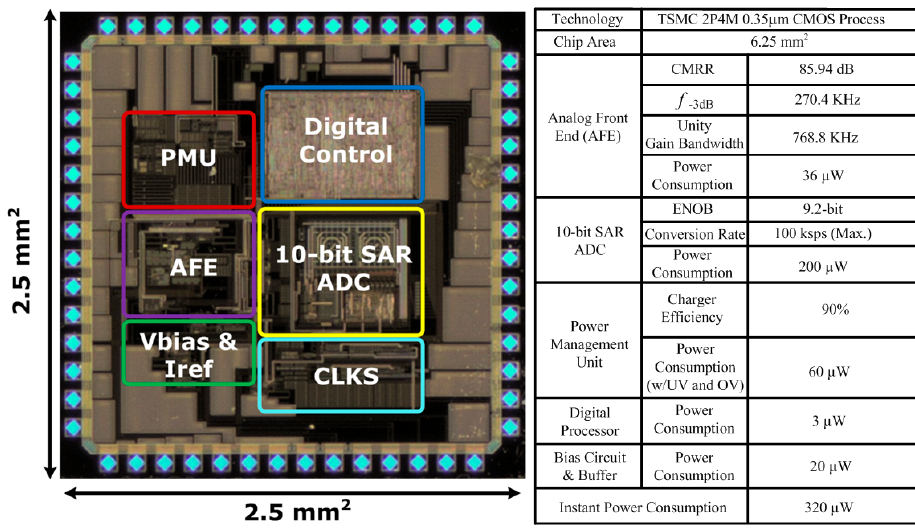
Figure 5. The die photo of the designed SoC and its measured performance.